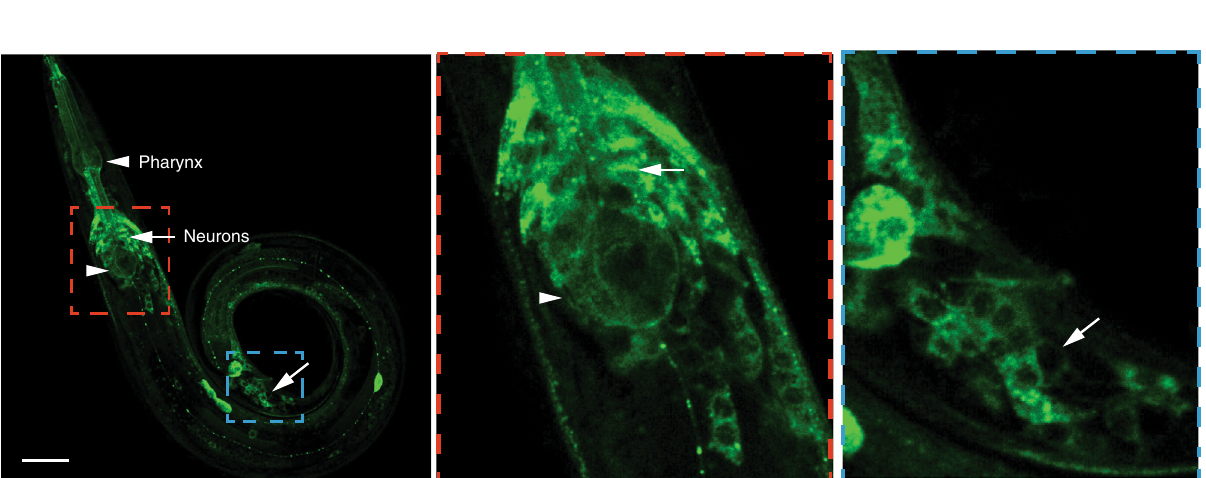
Fig. 2 MALT-1 is expressed widely in the nervous system. A transgene expressing C-terminally GFP-tagged MALT-1 from its endogenous promoter (4 kb of upstream DNA) is expressed broadly in the nervous system, including many neurons in the head (red box) and tail (blue box). MALT-1::GFP expression is also seen throughout the pharynx. Similar results were obtained in 3 experiments. White arrows point to neurons, arrowheads point to the pharyngeal bulbs. Scale bar: 20 μ m. See also Supplementary Fig.